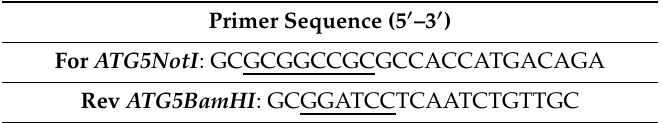
Table 1. Sequence of primers used for cloning.